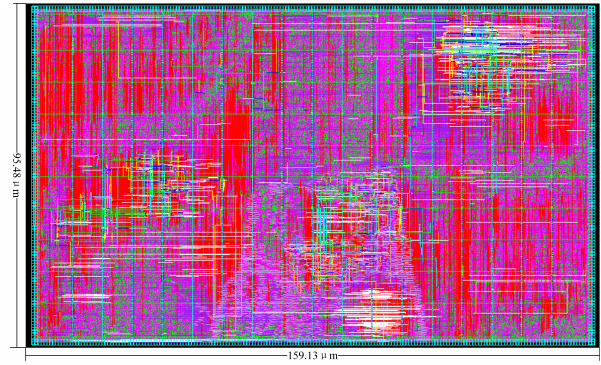
Figure 11. IC hardware layout.